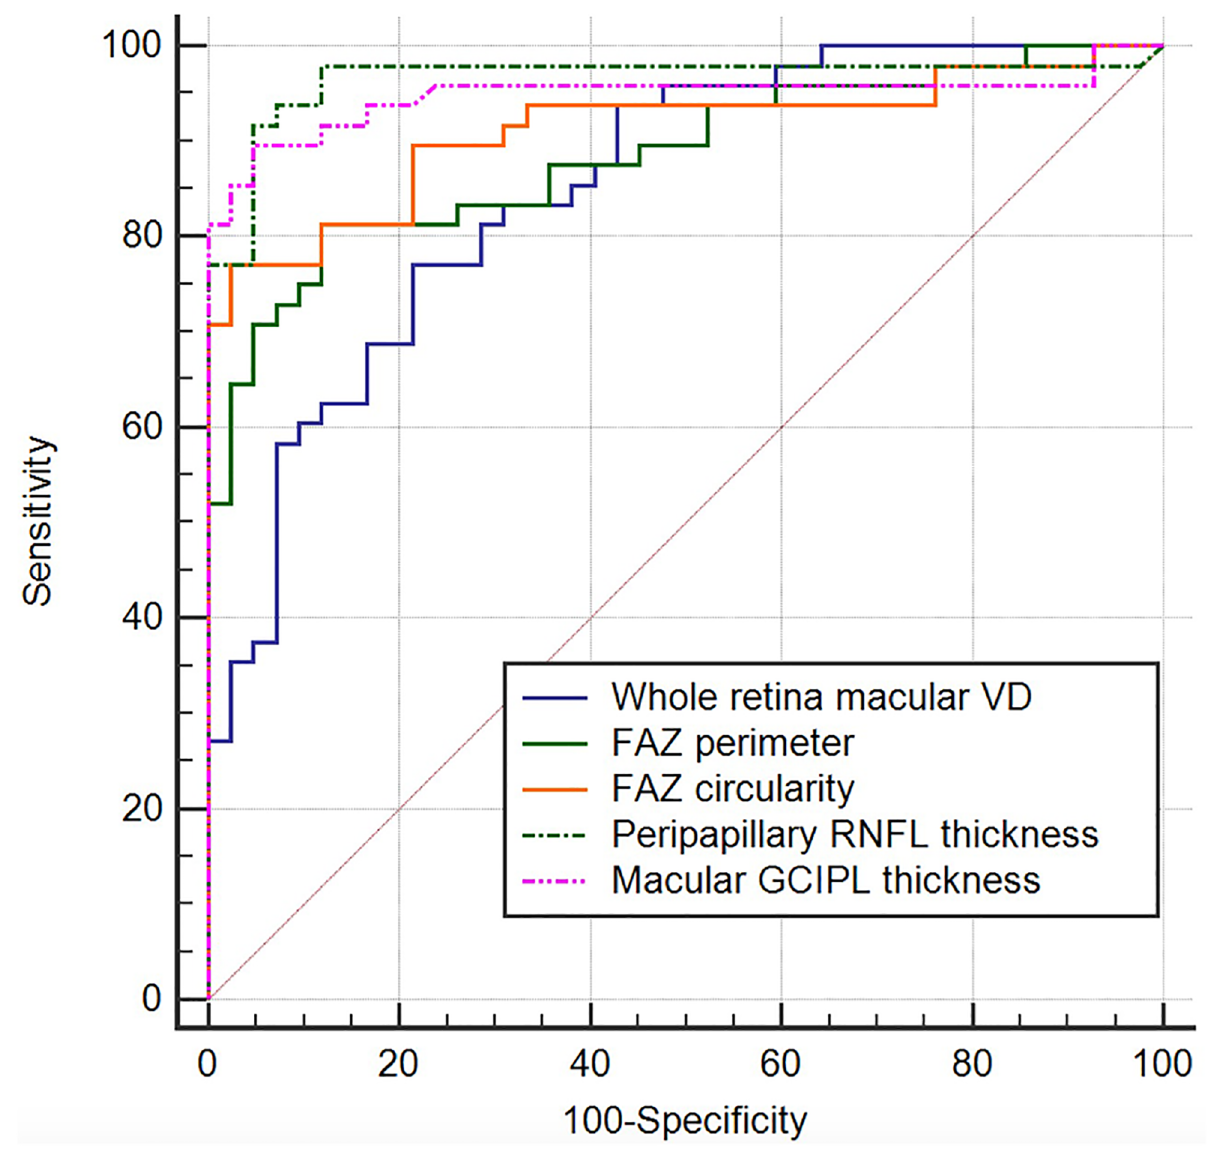
Fig 3. Refractiveerror-adjusted receiveroperating curves for whole retina macularVD, FAZ perimeter, FAZ circularity index, peripapillary RNFL thickness, and macular GCIPL thickness.